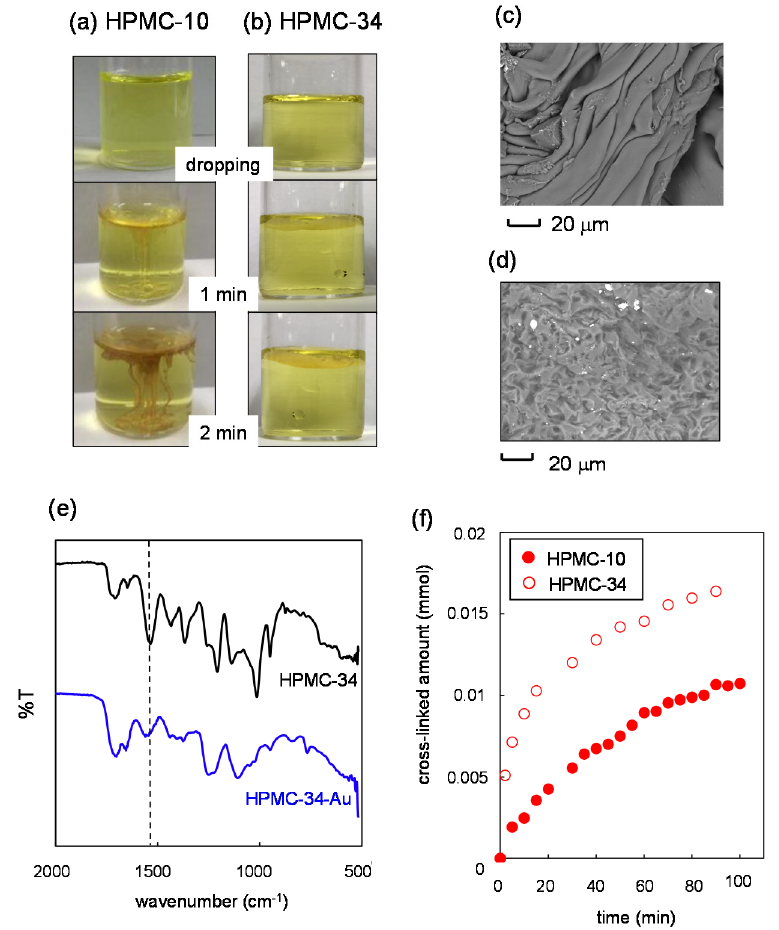
Figure 2. Gelation behavior of Au III with ( a ) HPMC ― 10 and ( b ) HPMC ― 34. SEM images of ( c ) HPMC ― 10 ― Au and ( d ) HPMC ― 34 ― Au. ( e ) IR spectra of HPMC ― 34 and HPMC ― 34 ― Au. ( f ) Cross-linking rates of HPMC ― 10 and HPMC ― 34.